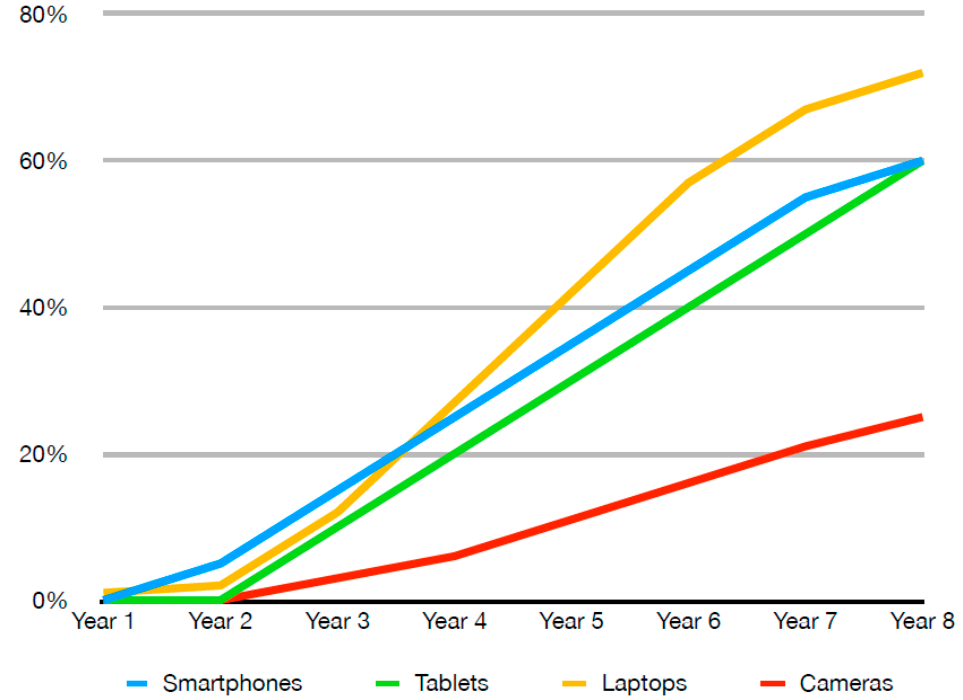
Figure 3. Export ratio of portable electronics that contain LIBs in Europe and the United States (estimate courtesy of Circular Energy Storage).